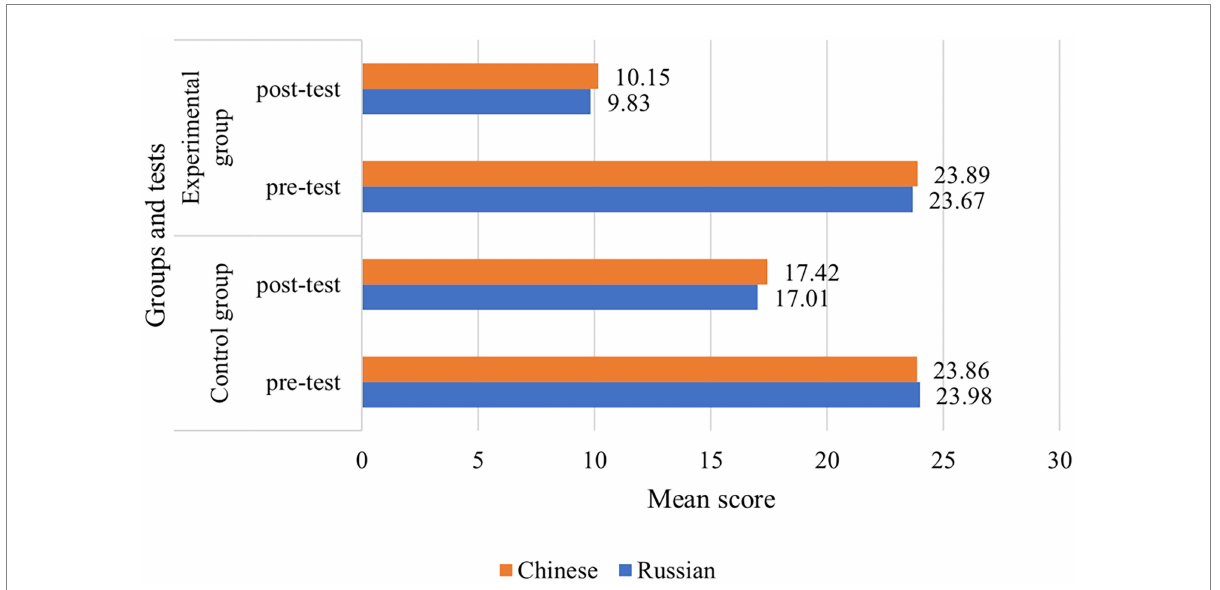
FIGURE 2 Pre- and post-test results separated by level of fear of starting training, %.